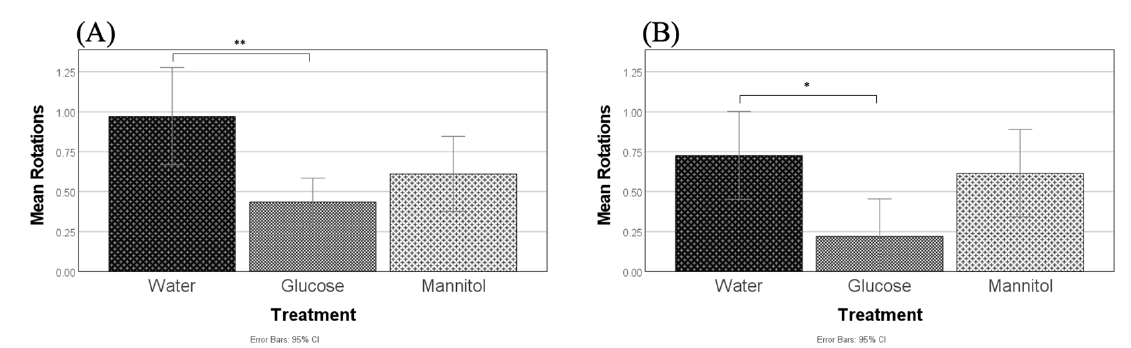
Figure 10. Optomotor responses. Optomotor responses (OMRs) were measured after ( A ) 8 weeks and ( B ) 12 weeks of hyperglycemia. At both timepoints, one-way ANOVA identified reduced positive OMRs in glucose-treated fish compared to water-treated controls (8-weeks, p = 0.002, **; 12-weeks, p = 0.033, *). Values presented are means +/ − 95% CI.